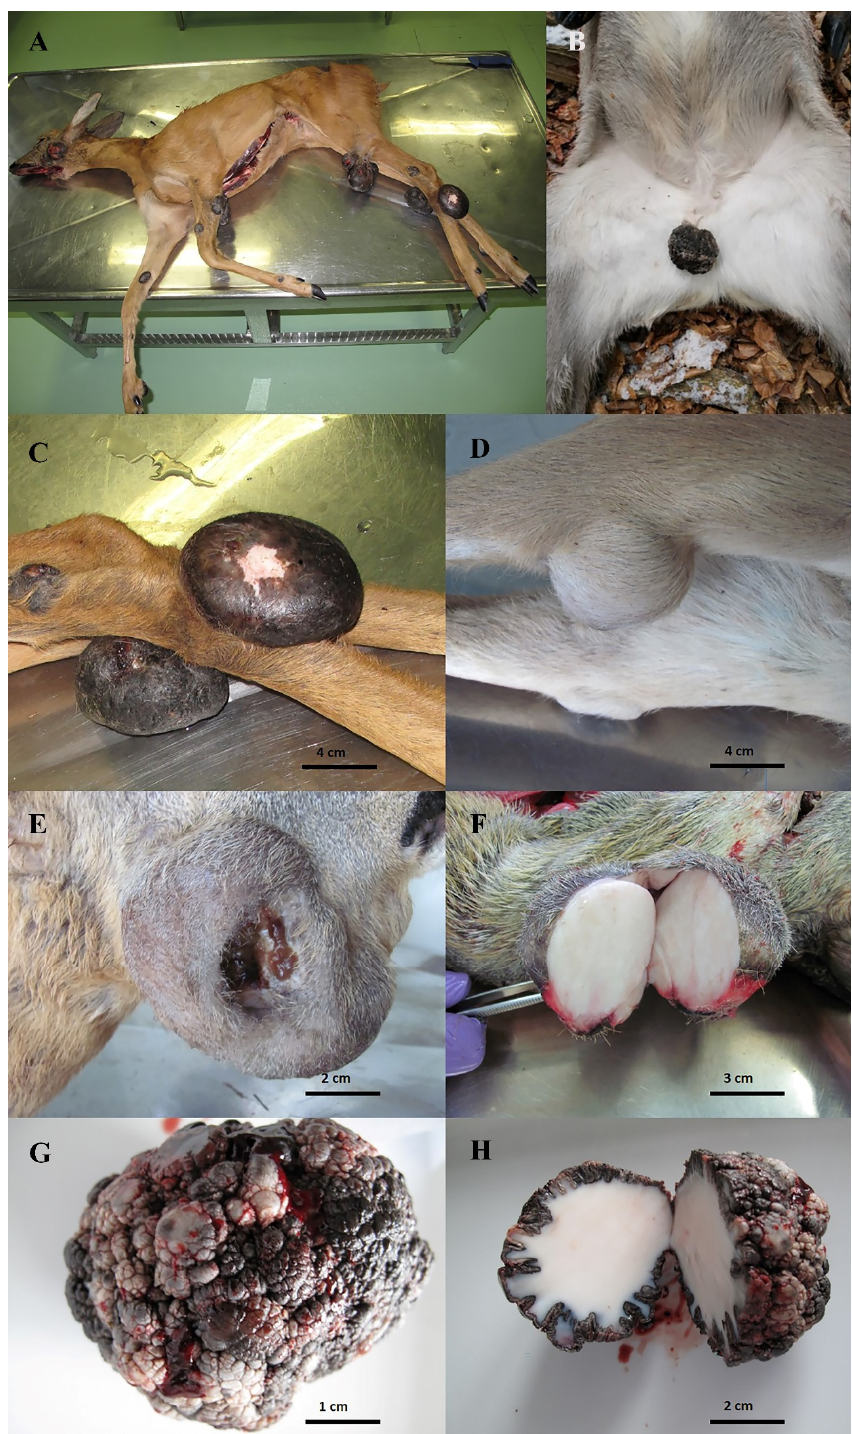
Figure 2. ( A )Macroscopiclesionsoffibropapillomasofvarioussizeslocalisedontheheadandextremities of an infected roe deer. ( B ) Macroscopic lesion of solitary fibropapilloma of an infected red deer in the groin area. ( C ) Pedunculated, round, firm, pigmented, eroded and hairless fibropapillomas of a roe deer. ( D ) Round, firm and hairy fibropapilloma of a roe deer. ( E ) Large, ulcerated fibropapilloma of a roe deer. ( F ) Cut surface of a roe deer fibropapilloma with a compact, shiny and white appearance of the firm connective tissue. ( G ) Fibropapilloma of a red deer showing a cauliflower-like mass and a hairless and pigmented surface. ( H ) Cut surface of a red deer fibropapilloma with a compact, shiny and white appearance of the firm connective tissue and a pronounced papillary structure of the external